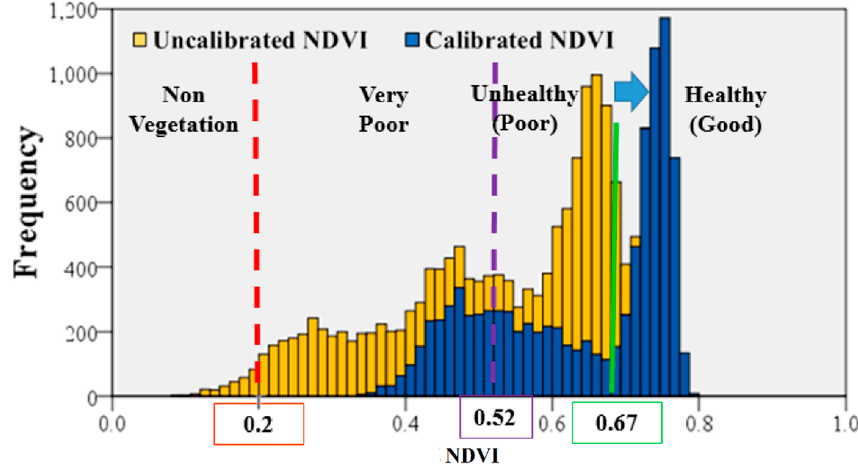
Figure 18. NDVI frequency shift before and after the calibration of NDVI measured by the UAV.